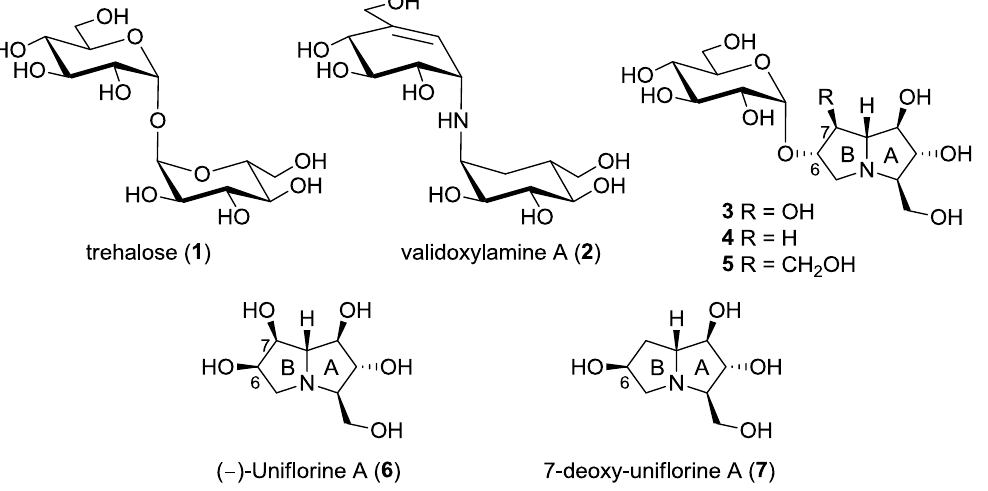
Figure 1. Trehalose ( 1 ), the natural substrate of the enzyme α-trehalase (EC 3.2.1.28), and some natural and non-natural trehalase inhibitors reported to date.